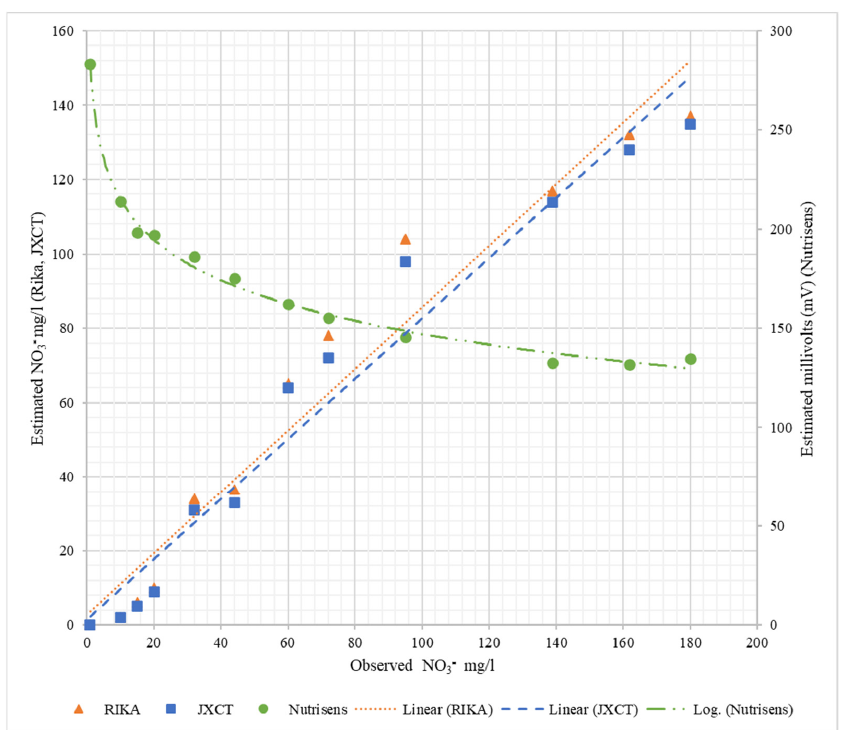
Figure 9. Behavior of the probes at different nitrate concentrations in liquid medium. On the x -axis is the observed nitrate concentration, on the left y -axis is the estimated nitrate concentration for Rika and JXCT, and on the right y -axis is the estimated millivolts for Nutrisens. Table 3. Fitting and the determination coefficients for the probes when increasing the nitrate con- centration in liquid medium.